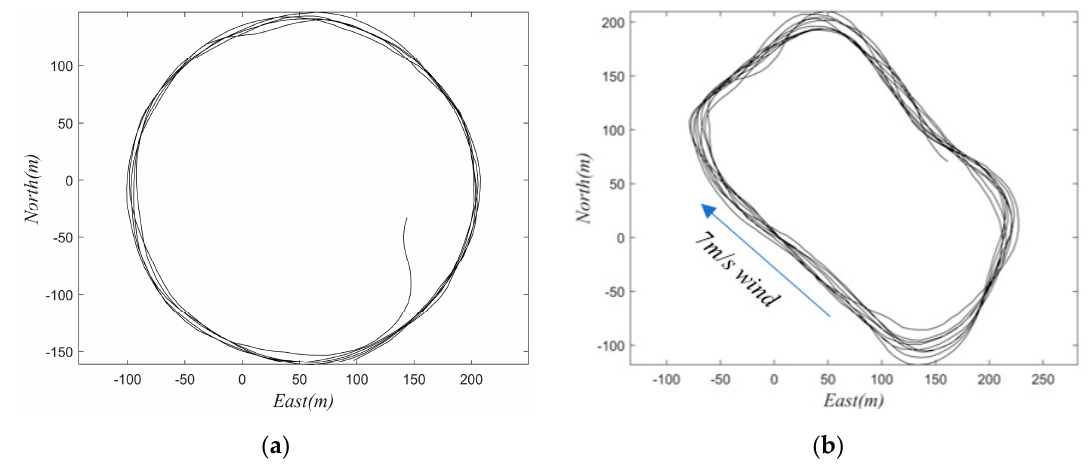
Figure 18. The flight path of the solar-powered UAV: ( a ) Circular flight path without wind, ( b ) quadrilateral flight path with 7 m/s wind.